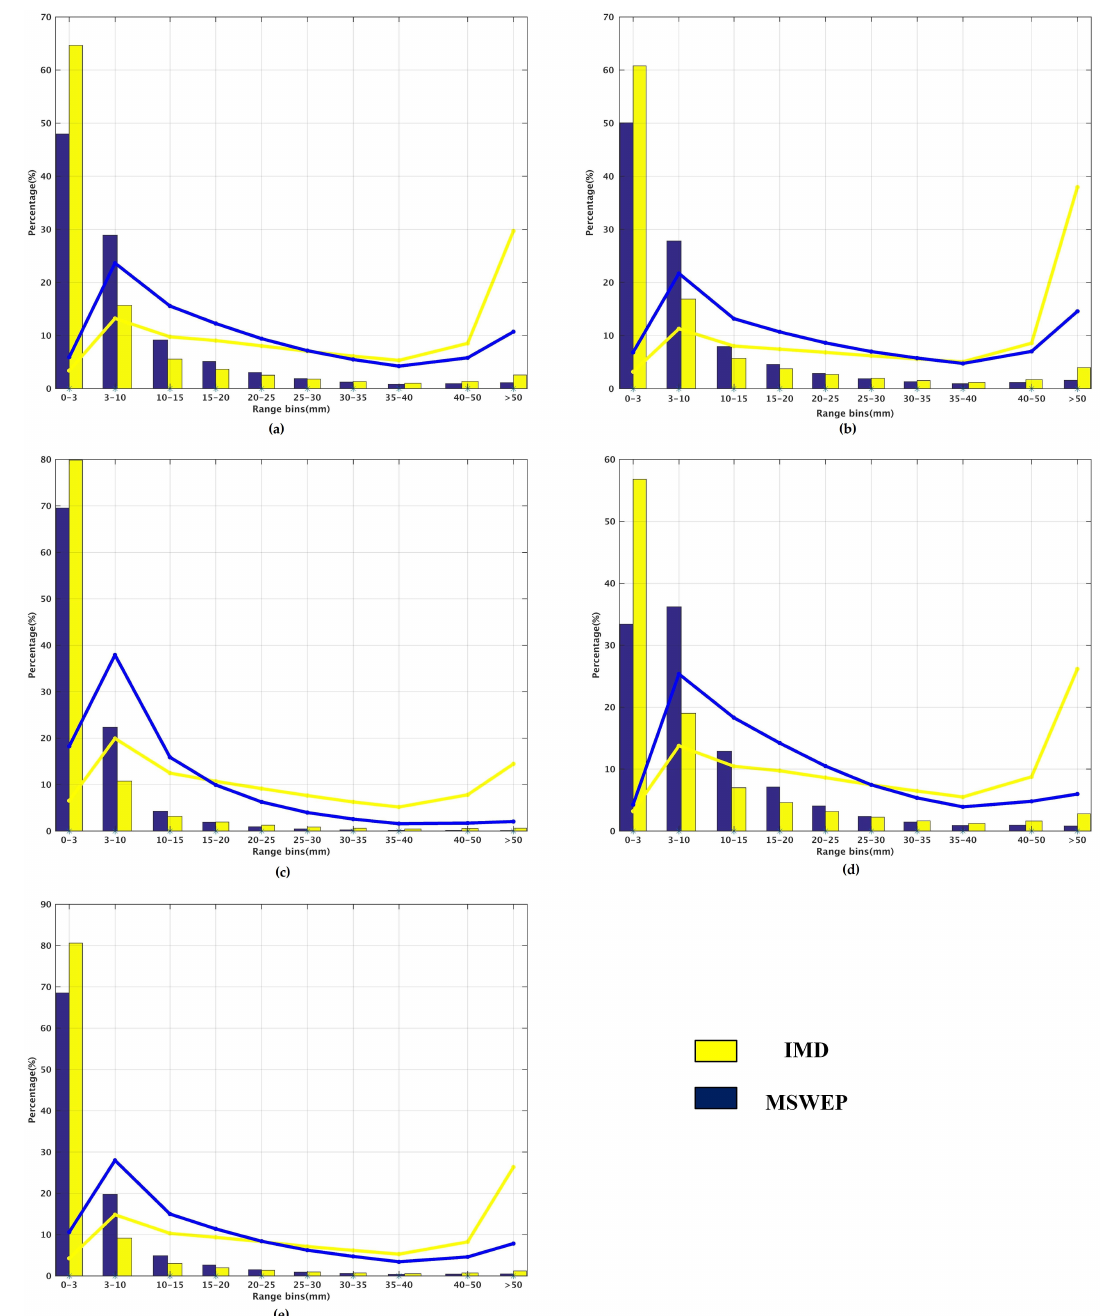
Figure 4. Distribution of daily rainfall in different rainfall classes and their relative contributions to the total rainfall in different grids for monsoon season (June, July, August, September) (JJAS): ( a ) all India; ( b ) southwest India; ( c ) southeast India; ( d ) central India; ( e ) northwest